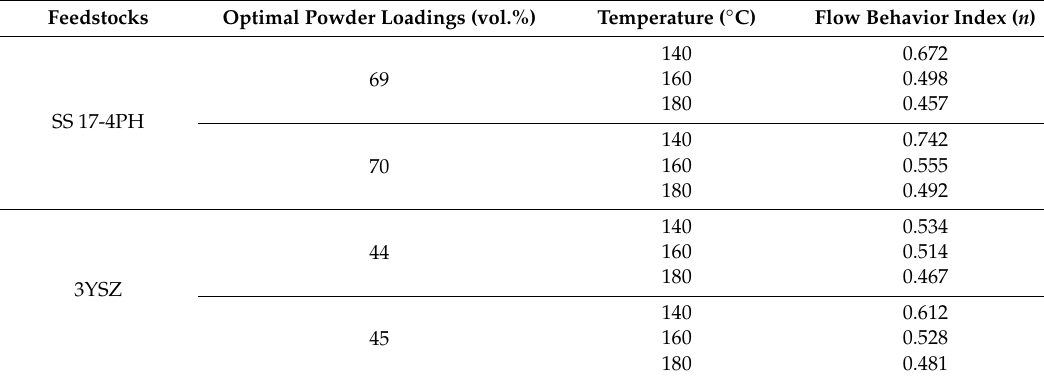
Table 2. Values of 𝑛 for SS 17-4PH and 3YSZ feedstocks at different temperatures. Feedstocks Optimal powder loadings (vol.%)